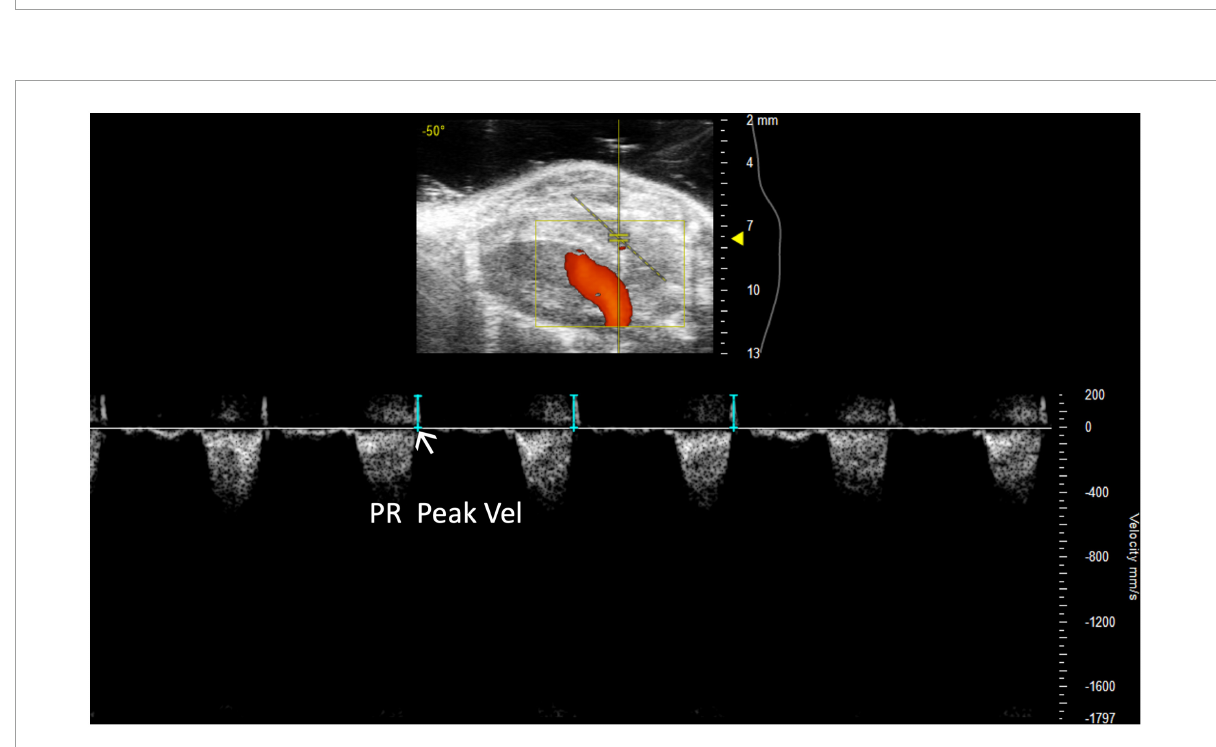
FIGURE6 Representative image displaying pulmonary regurgitation peak velocity (PR Peak Vel), a parameter used in mouse models of pulmonic regurgitation which is acquired in pulsed wave Doppler mode of the parasternal long axis (PLAX)